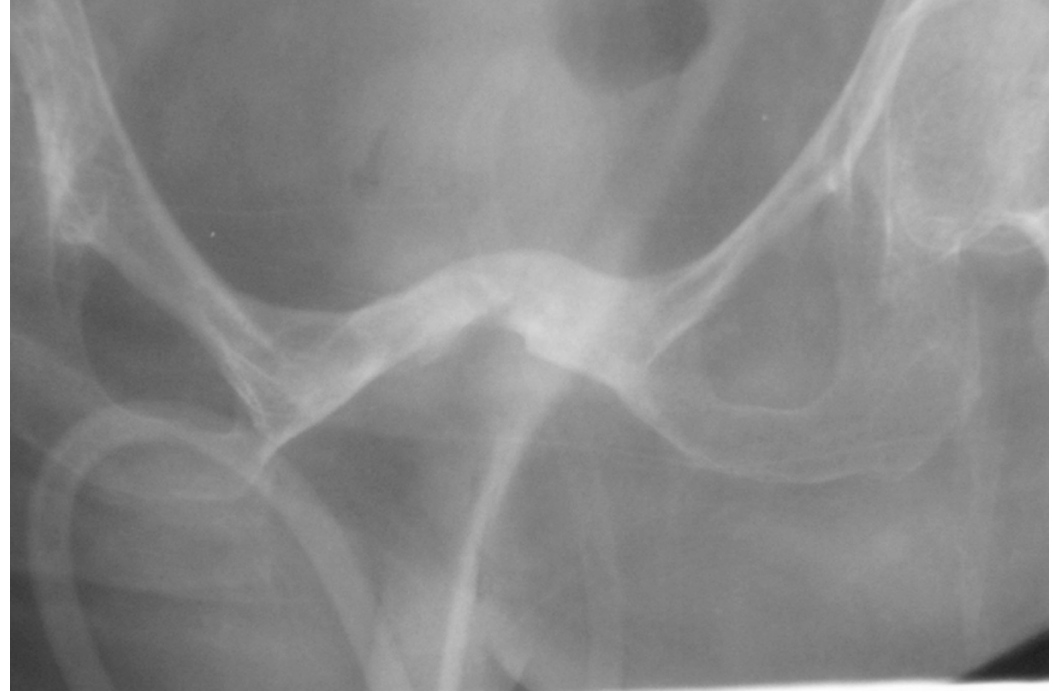
FIGURE 2. X-ray of pelvis, taken on 23 June 2006, shows heterotopic bone formation producing bony ankylosis of pubis in this patient, who was born with spina bifida and diastasis of symphysis pubis. Inferior margin of heterotopic bone, especially on the left side, is